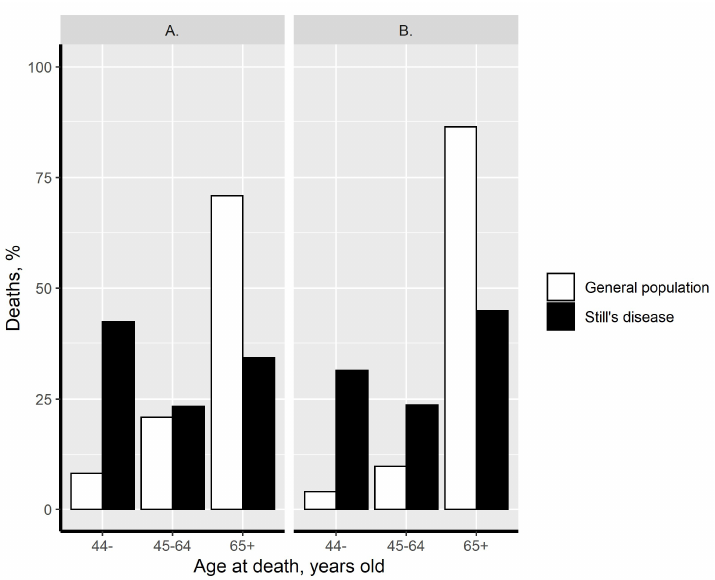
Figure 1. Distribution of deaths according to age. The distribution of Still’s disease-related deaths (black bars) and that in the general population (white bars) according to age is presented among men (A) and women (B).